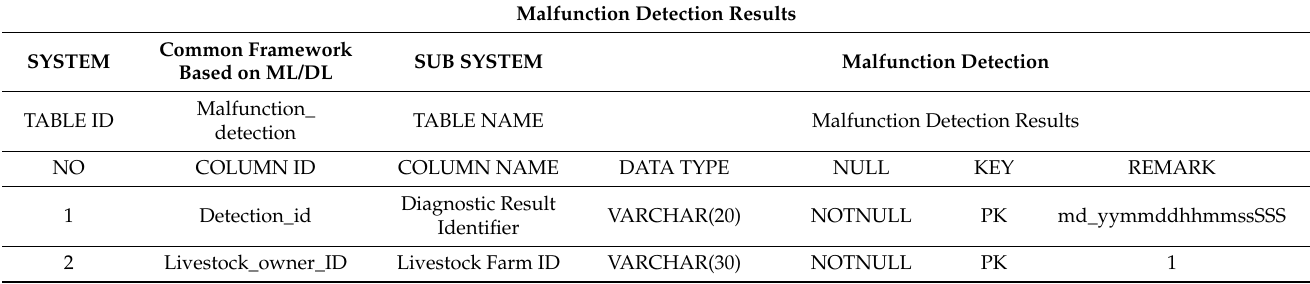
Table 2. Database showing the results of malfunction detection and the corresponding responses, including the contents of the notification sent to the